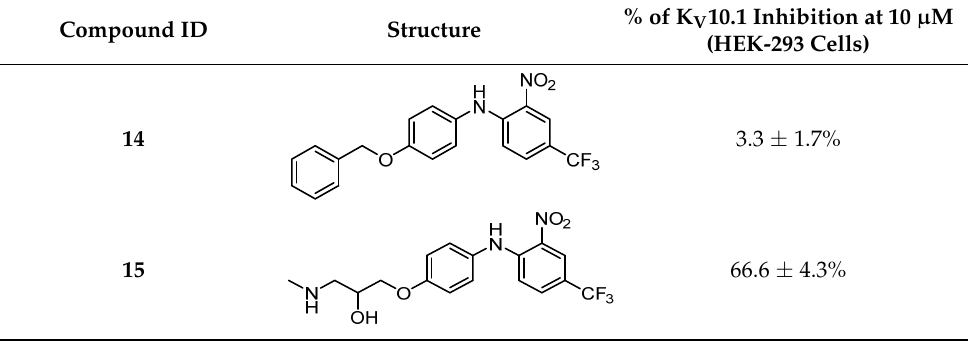
Table 3. Structures and potencies of compounds from Strategy III.